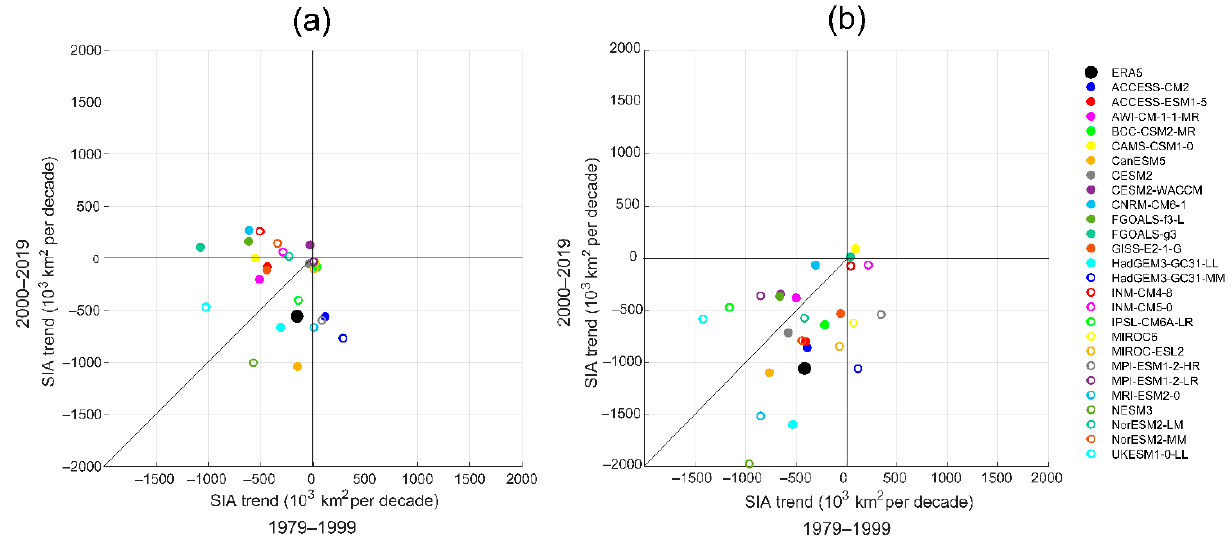
Figure 6. Relationship between Arctic SIA trends in 1979–1999 and 2000–2019 for 26 CMIP6 models and ERA5 data in ( a ) March and ( b ) September.